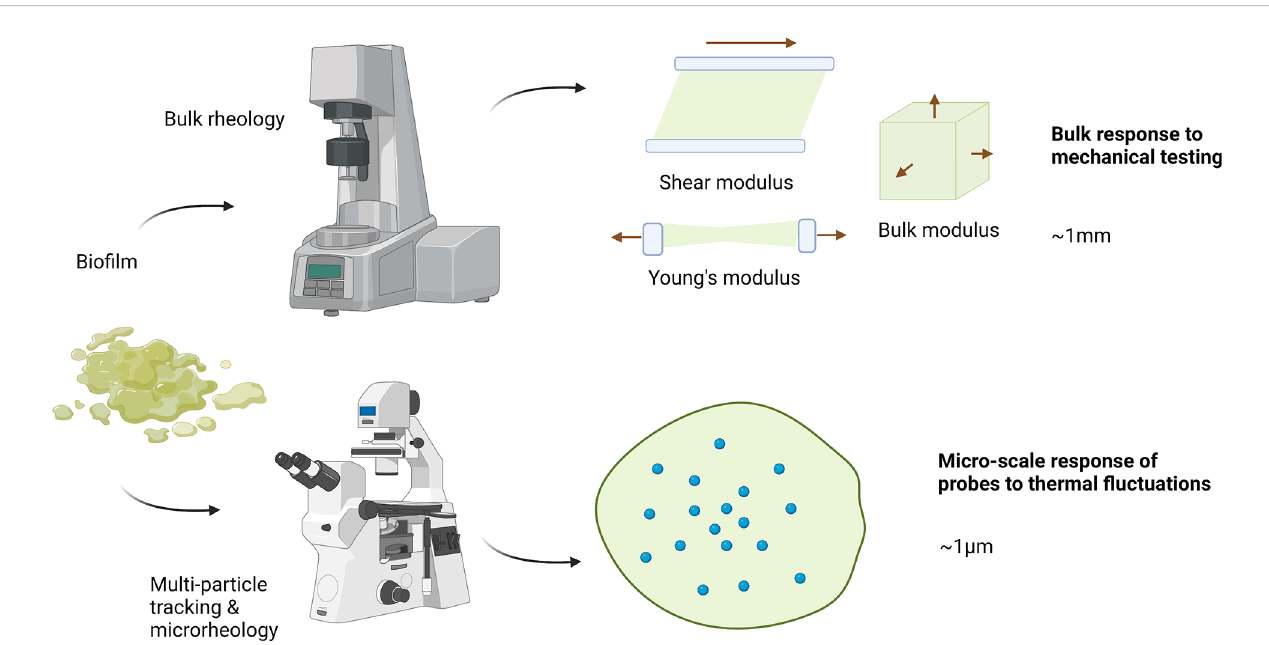
FIGURE 1 Bulk rheology and micro-rheology approaches for measuring bio fi lm mechanics. Typical bulk rheology grows a sample ex situ , which is then loaded into a holder and has a particular deformation applied. To measure shear moduli, the sample is typically placed in parallel plates ~ 1mm apart on a rotational rheometer. The plates apply a controlled stress or strain shear deformation, taking into account plate diameter and gap. For extension or compression measurements, typically a dynamic mechanical analyzer is used that has a range of sample holders which similar dimensions. In multi-particle tracking microrheology samples are grown in situ with particles within a sample holder. This system is then directly placed onto a microscope and particle motion is tracked. Typical particle sizes are ~ 1 micron. Created with